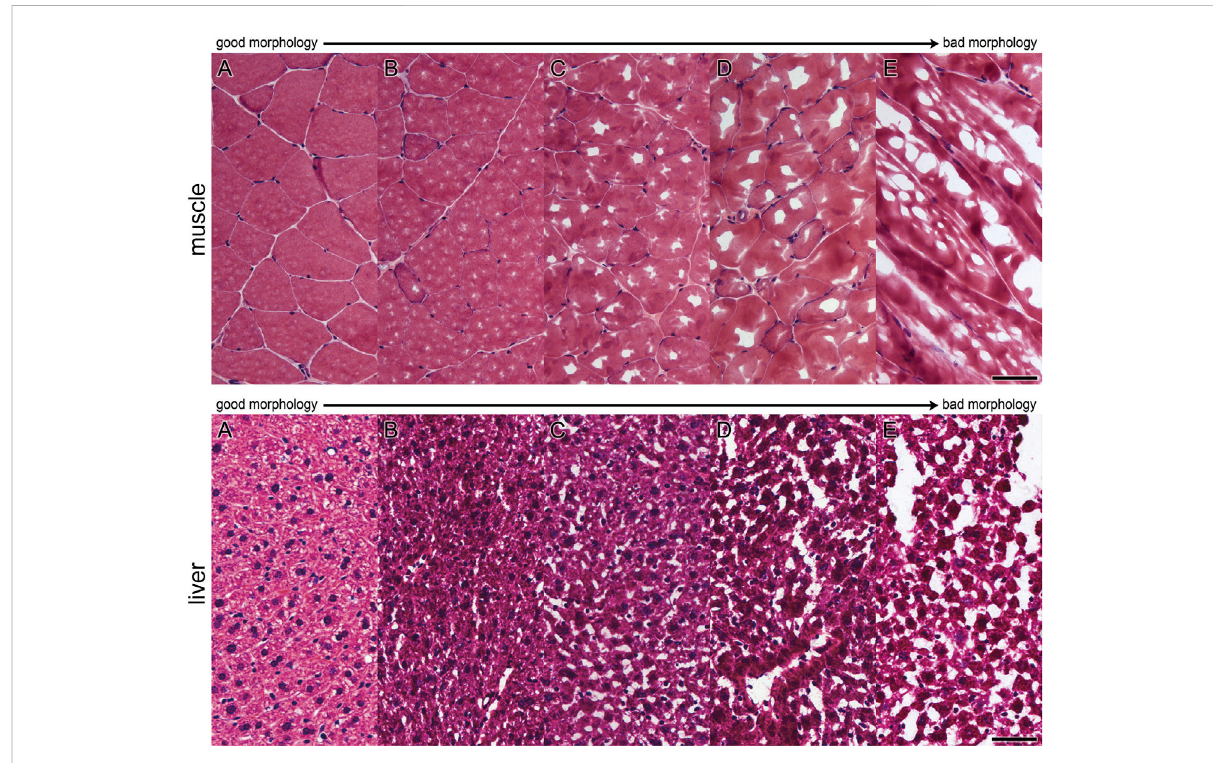
FIGURE 1 Evaluation scheme for assessment of morphological quality of areas. Morphology was evaluated on H&E-stained cryosections. Single areas wereassignedtogradingcriteriashowninpictures (A – E) formuscleandlivertissue (A) :verygood, (B) good, (C) acceptable, (D) bad, (E) verybad)[Bar (A – E) : 50